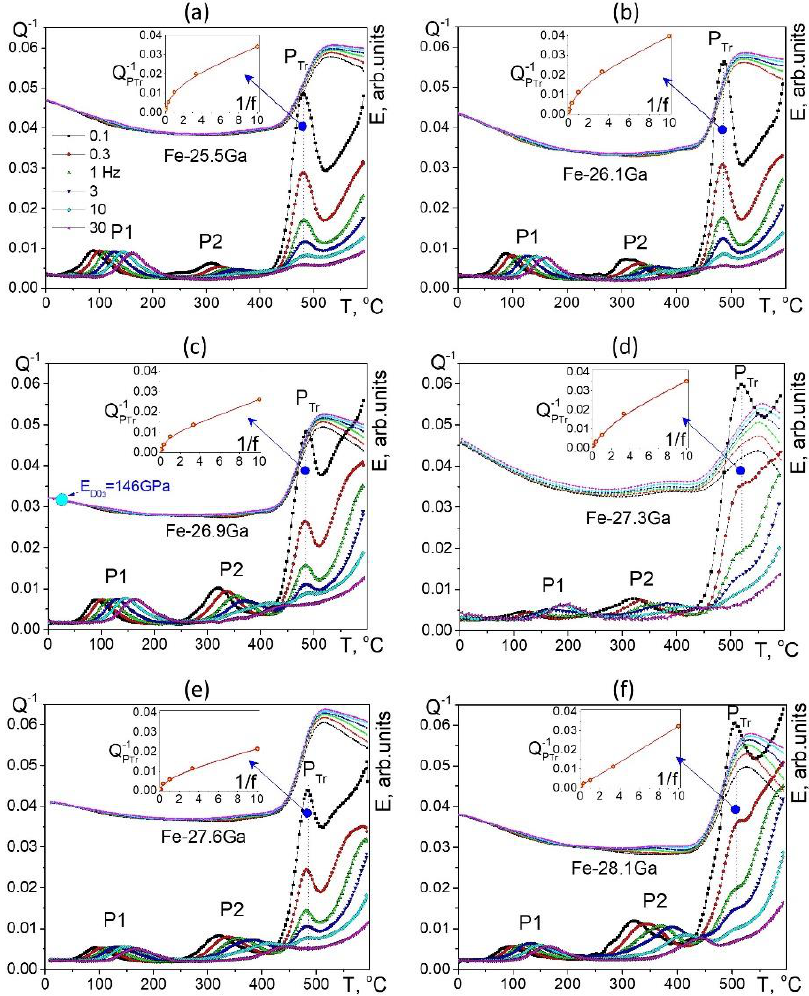
Figure 18. TDIF curves at heating with a rate of 2 °C/min for the Fe–25.5Ga ( a ), Fe–26.1Ga ( b ), Fe–26.9Ga (with absolute value of elastic modulus at RT) ( c ), Fe–27.3Ga ( d ), Fe–27.6Ga ( e ), and Fe28.1Ga ( f ) alloys. Insets: dependences of the peak height on inverse frequency.